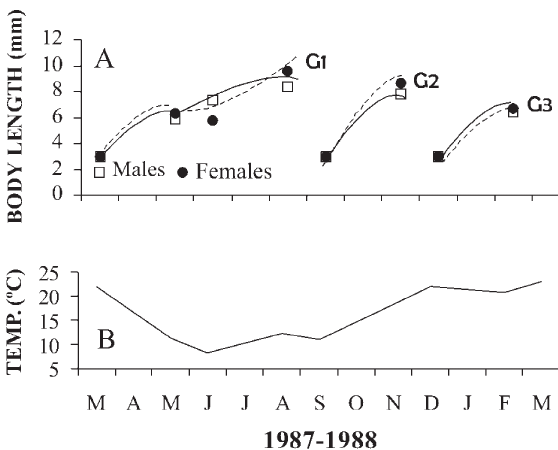
F IG . 8. – (A) Oversimplification of the growth curve of the three annual generations (G1, G2 and G3) estimated for Neomysis amer- icana. (B) Evolution of temperature values during the study year. See Table 1 for more details.